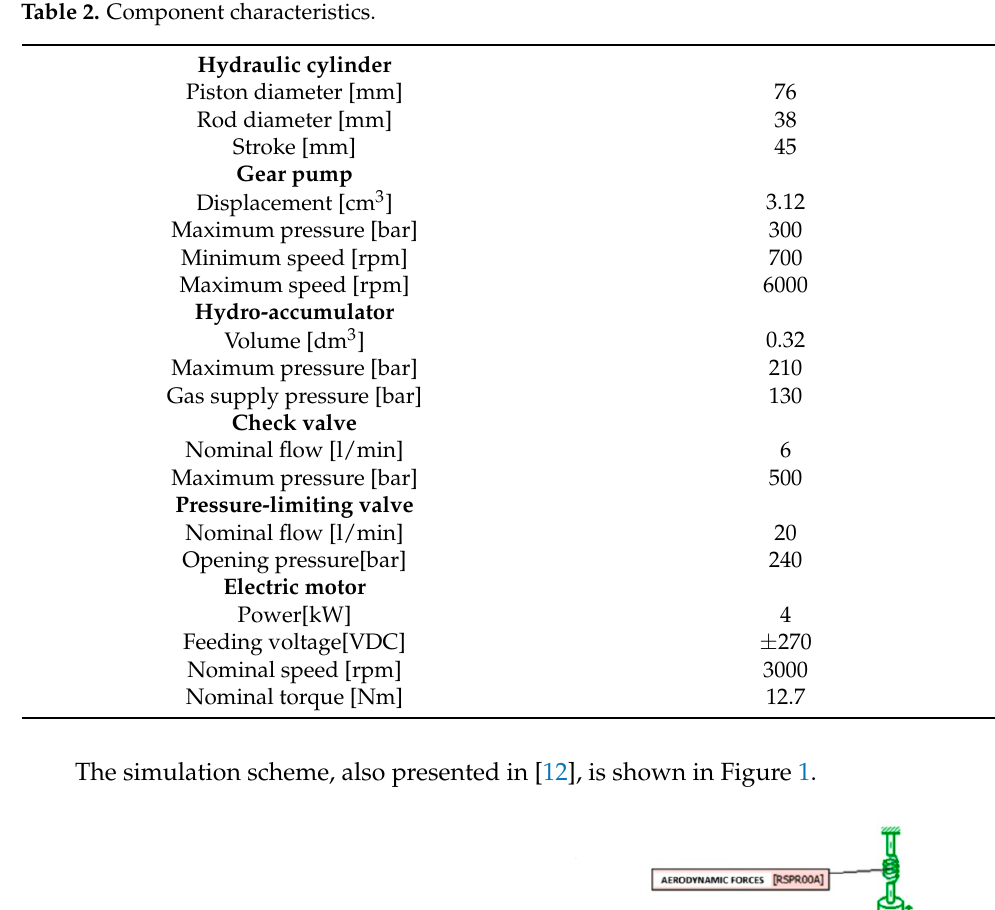
Table 2. Component characteristics.